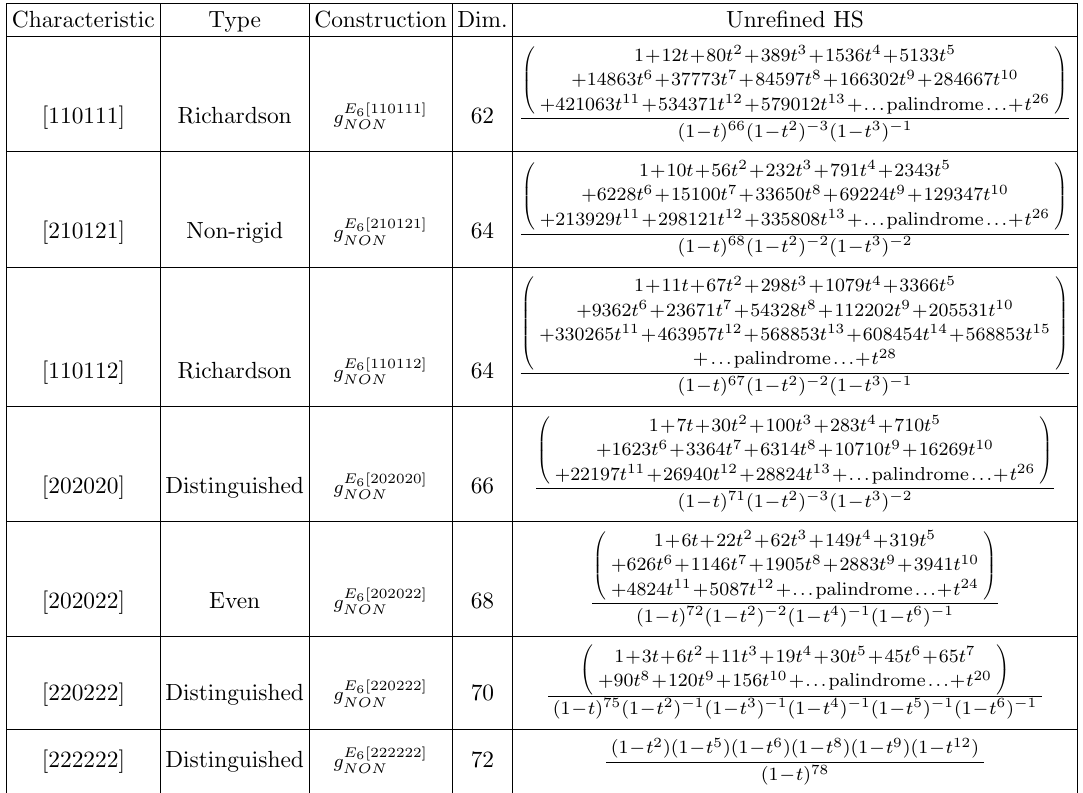
Table 14 . E 6 orbit constructions and Hilbert series